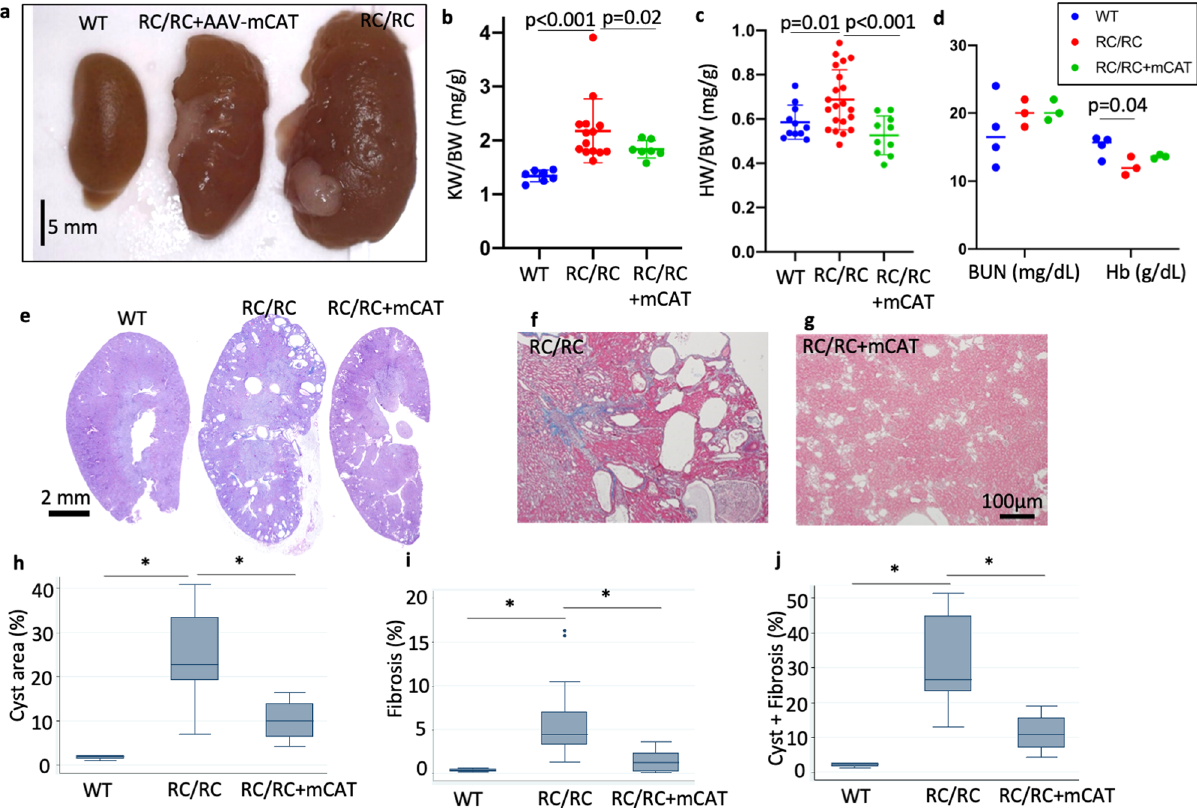
Fig. 3 Overexpression of mCAT ameliorates kidney pathology, cystic enlargement, and fi brosis in RC/RC mice. a Gross pathology of kidneys from 6 − 7- month-old WT and RC/RC mice or RC/RC mice that received low dose injection (2 × 10 9 /g) of AAV9-mCAT (RC/RC + AAV9-mCAT) (representative image shown; n = 4 − 6). b Kidney weight and c heart weight normalized to body weight in mice of the indicated genotypes and treatment groups; n = 10 − 21. d Blood urea nitrogen (BUN; mg/dL) and Hemoglobin (g/dL) in mice of the indicated genotypes and treatment groups; n = 3 − 4 per group. e Representative PAS staining of kidney sections from WT, RC/RC, and RC/RC treated with AAV9-mCAT. f , g Trichrome staining of kidney section from RC/RC and RC/RC treated with AAV9-mCAT. Quantitative analysis of h cysts area, i fi brotic area, and j combined cysts and fi brotic area. * p < 0.05.; ( n = 4 for WT, n = 15 − 18 for each of the other